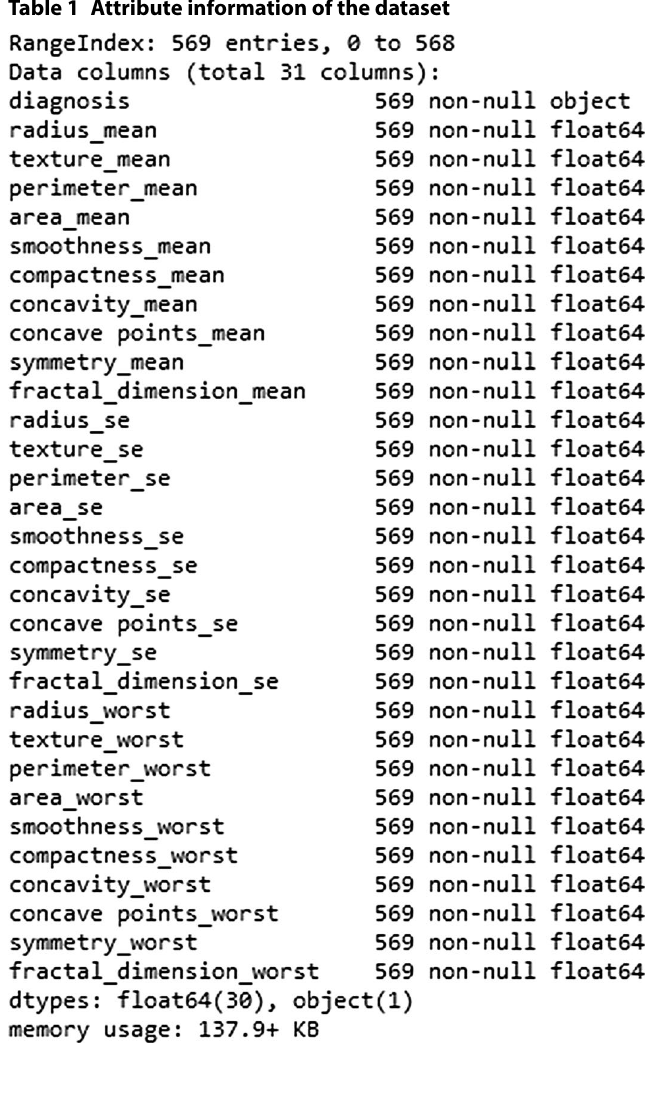
Table 1 Attribute information of the